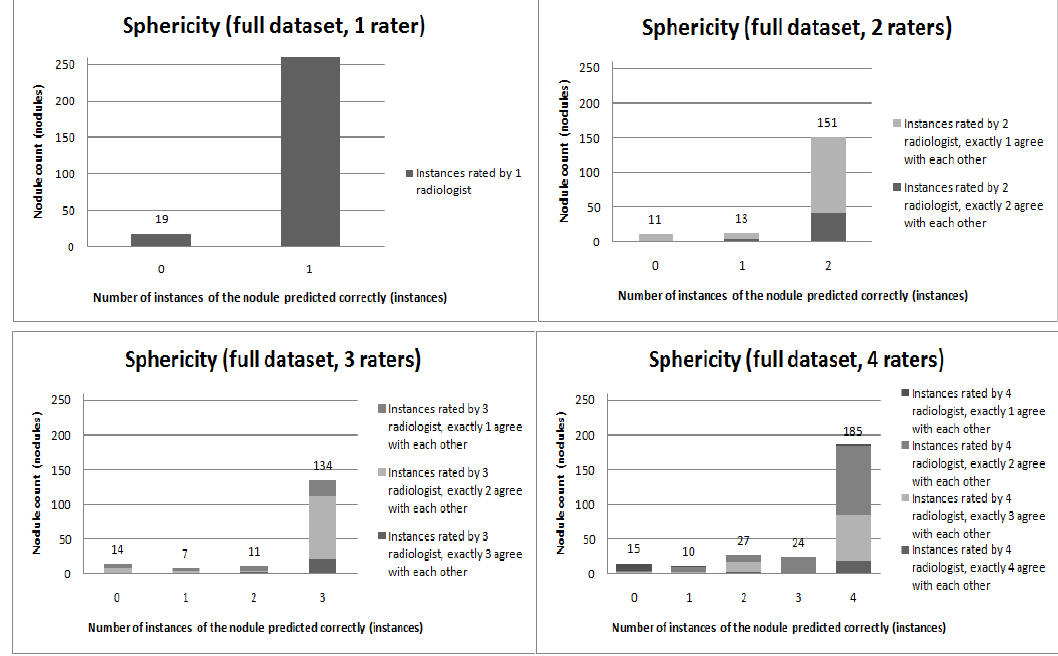
Figure 9. Visual overview of the ensemble of classifiers’ agreement with the panel of experts’ opinions